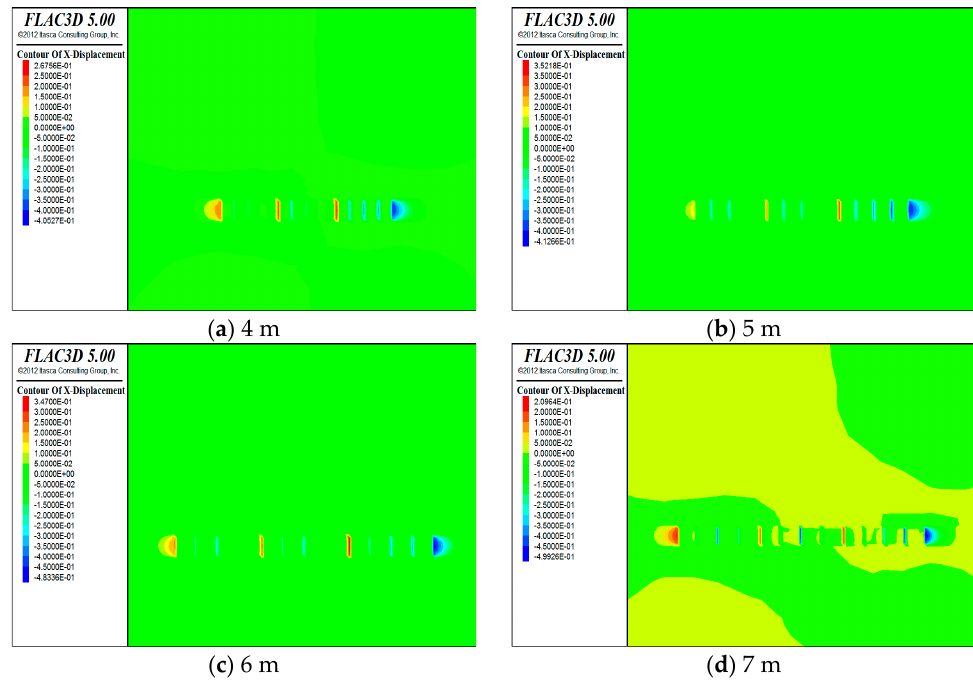
Figure 8. Horizontal displacement cloud for ( a ) 4 m, ( b ) 5 m, ( c ) 6 m, and ( d ) 7 m. From the analysis of the deformation of the surrounding rock during the four rounds of option I, it can be seen that the movement deformation of the overburden rock and the ground surface under different mining width conditions are different. Figures 9 and 10 and Table 4 show that the mining width is small, the overburden sinking is small, which is beneficial to the control of the roof; when the mining width reaches 7 m, the overburden sinking amount and sinking speed increase obviously, and the maximum sinking position is shifted from the center of the mining area to the interval coal column between working faces or the roof of the newly filled working face.